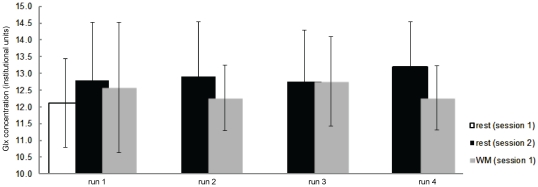
Changes in the Glx (glutamine plus glutamate) neurotransmitter concentration (with standard deviations) during session-specific rest (session 1: open bar, session 2: solid black bar) and working memory (session 1 only: solid grey bar) measurements.